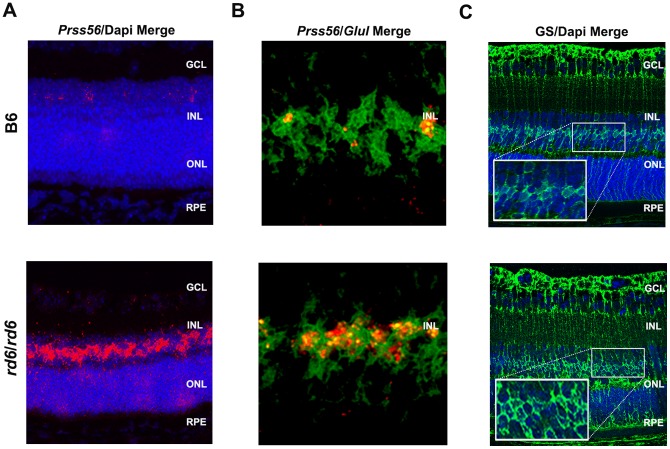
Cellular localization of Prss56 and Glul in B6 (C57BL/6J) and Mfrprd6/Mfrprd6 mice.(A) By in situ hybridization, in B6 (C57BL/6J) controls at P14, we observed Prss56 transcript in only very few cells of the inner nuclear layer (INL) of the retina (top panel), whereas in Mfrprd6/Mfrprd6 mutants, an intense staining of Prss56 transcript was observed in INL of the retina (bottom panel). (B) By 2-plex in situ hybridization, in B6 controls, we observed co-localization of Prss56 (red) and Glul (pseudo colored green) transcripts in only a few cell body of the (INL) of the retina (top panel), whereas in Mfrprd6/Mfrprd6, strong co-localization of Prss56 and Glul transcripts in the cell body of the INL of the retina was observed (bottom panel). (C) Glutamine synthetase (GS) staining of Müller cells. In both C57BL/6J (B6) and Mfrprd6/Mfrprd6 mice, Müller cells marked with glutamine synthetase showed a similar localization pattern (inset, top and bottom panels) as observed for Prss56 in situ hybridization staining, suggesting that Müller cells in the INL of retina express Prss56 transcripts at P14.